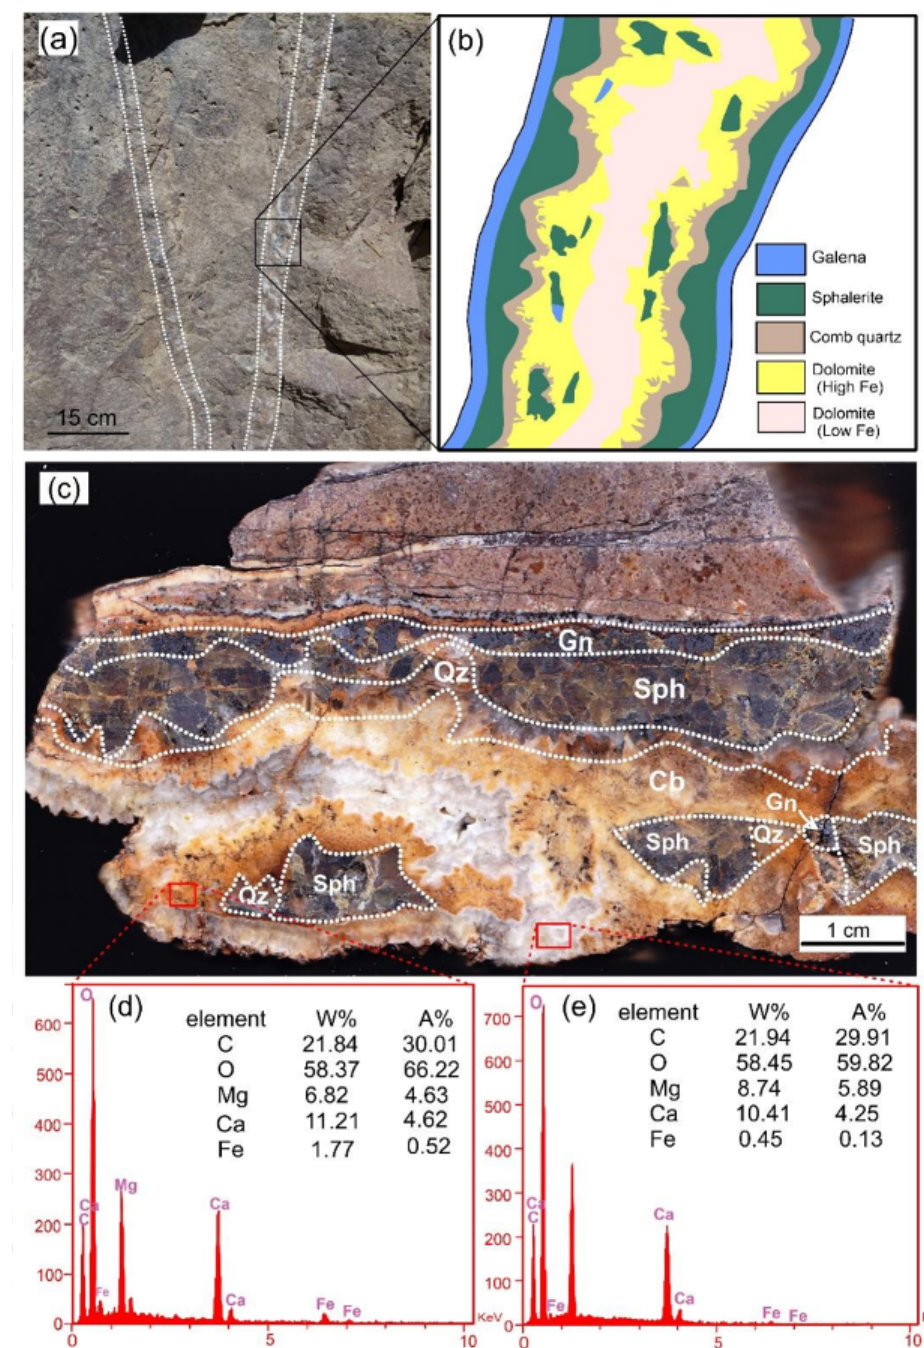
Figure 10. ( a ) Close-up view of silica-sulfide-carbonate vein; ( b ) Schematic representation of silica-sulfide-carbonate vein, illustrating multiple phases of mineral deposition and fracturing events; ( c ) Photographs of hand sample showing enlarged fractures filled with ore mineral clasts and carbonates; ( d ) The results of EDX analyses for relatively high Fe dolomite; ( e ) The results of EDX analyses for relatively low Fe